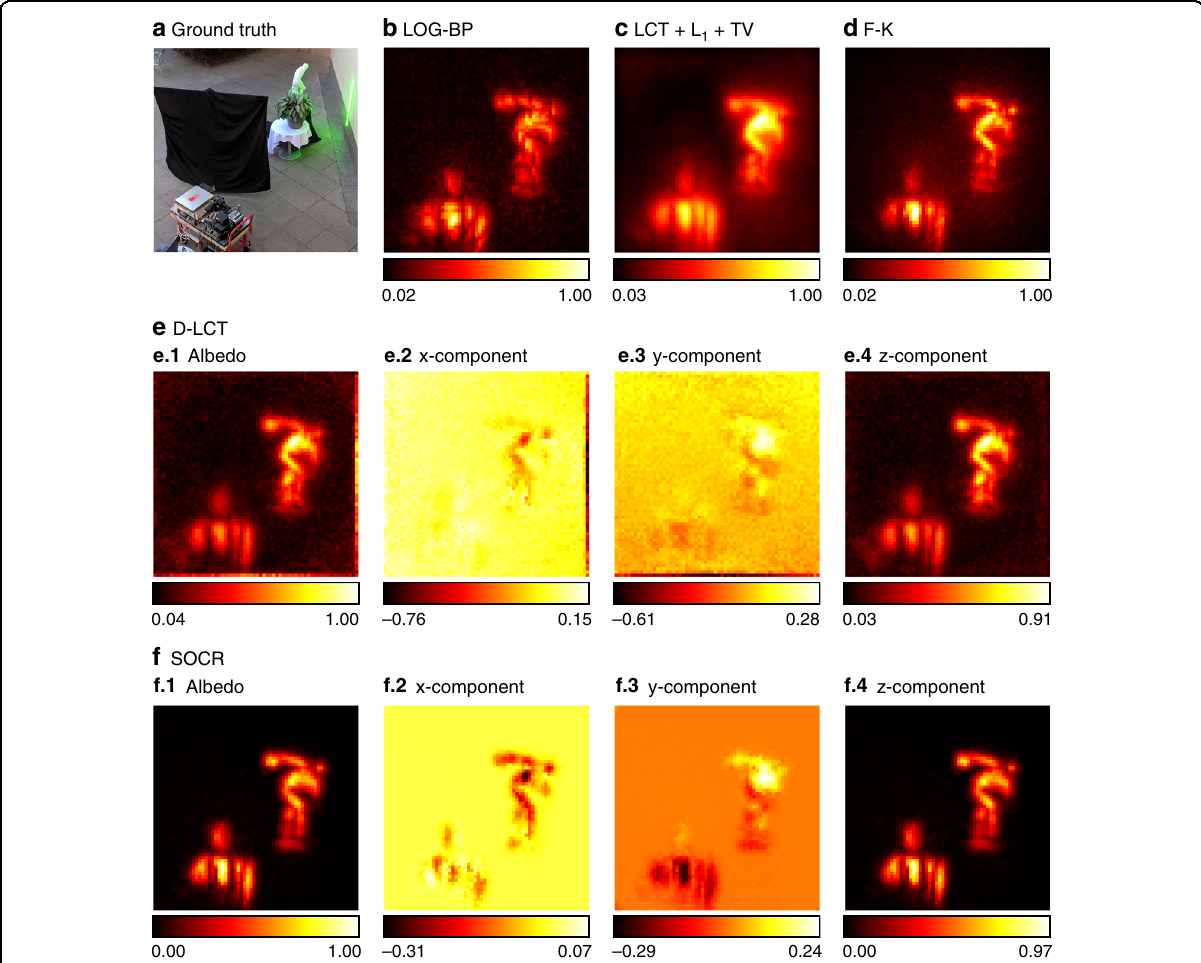
Fig. 11 Reconstruction results of the outdoor scene (confocal, 10 min). The experimental set-up is shown in a . Reconstructions are shown in b – f . The LOG-BP reconstruction is of low quality. Both the LCT + L 1 + TV and F-K reconstructions contain background noise. Our reconstruction has the highest